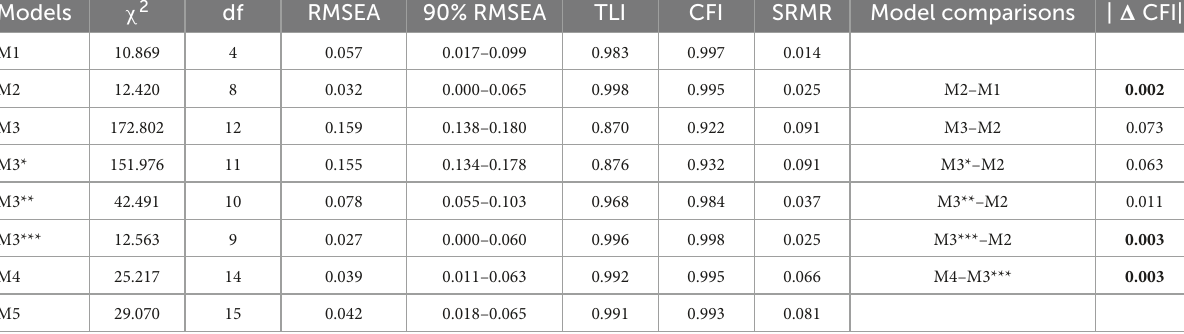
TABLE 5 Goodness-of-fit indexes for measurement invariance of the EQ-i between men and women.